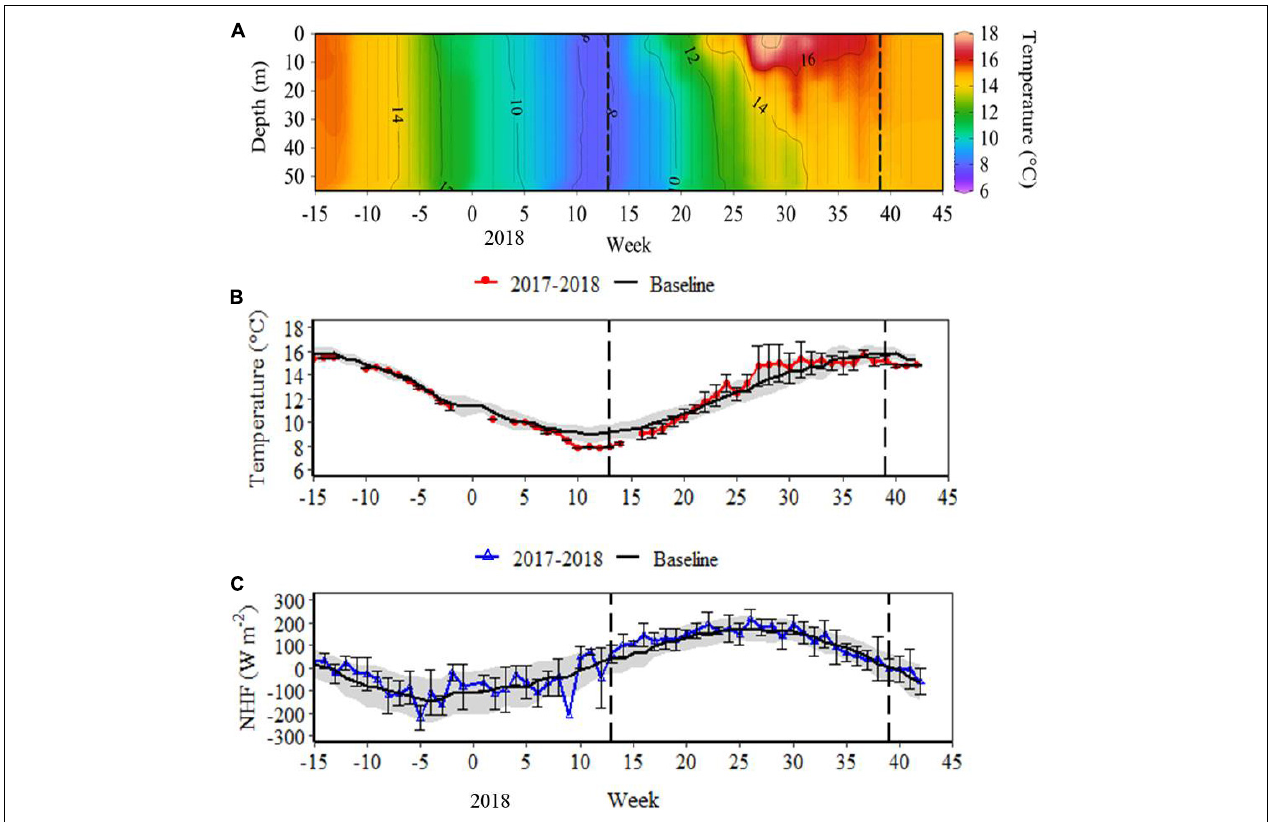
FIGURE 1 | (A) Water column temperature for the 2017–2018 study (Ocean Data View, Schlitzer, 2018); (B) depth-integrated temperature for the 2017–2018 study and weekly mean ( ± SD) depth-integrated temperature for the time series baseline (2002–2017); (C) surface net heat flux (NHF) for the 2017–2018 study and weekly mean ( ± SD) surface NHF for the time series baseline (1988–2017). In (B , C) , baseline standard deviation is represented by the grey band. Vertical dashed lines mark the onset and breakdown of stratification, indicated by the switch in surface NHF from negative to positive (week 13), and positive to negative (week 39) during the 2017–2018 study.